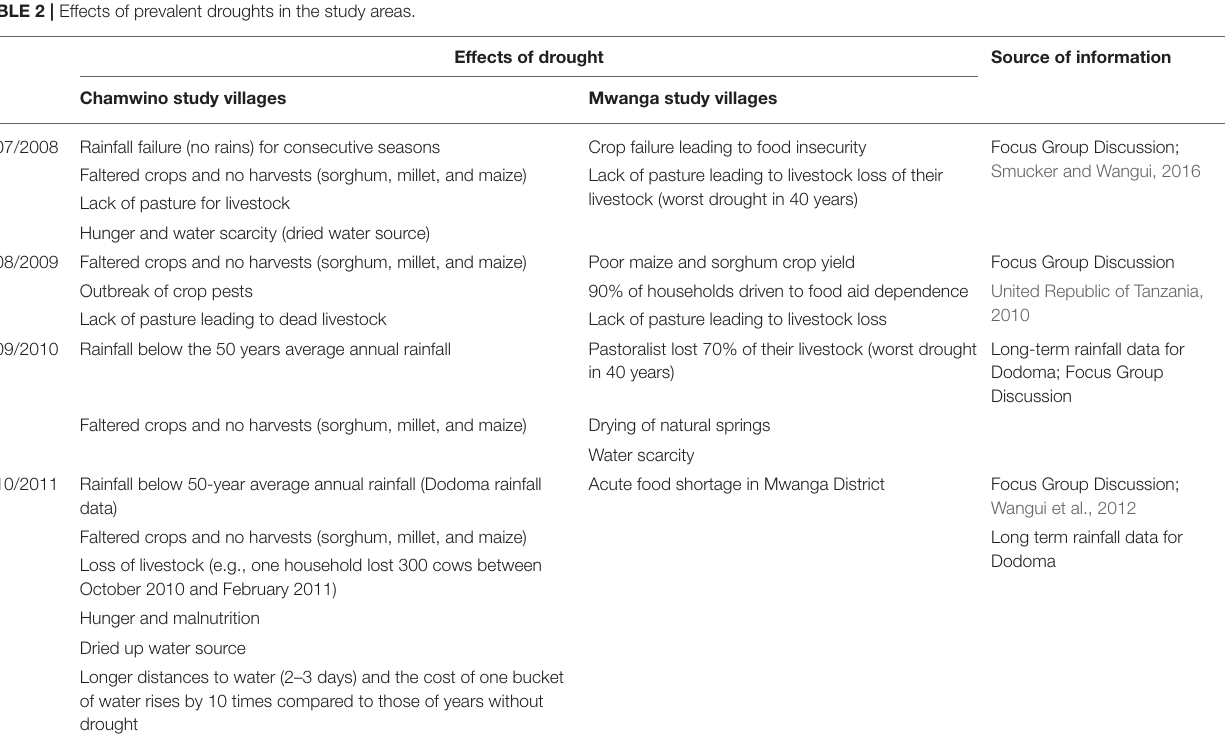
TABLE 2 | Effects of prevalent droughts in the study